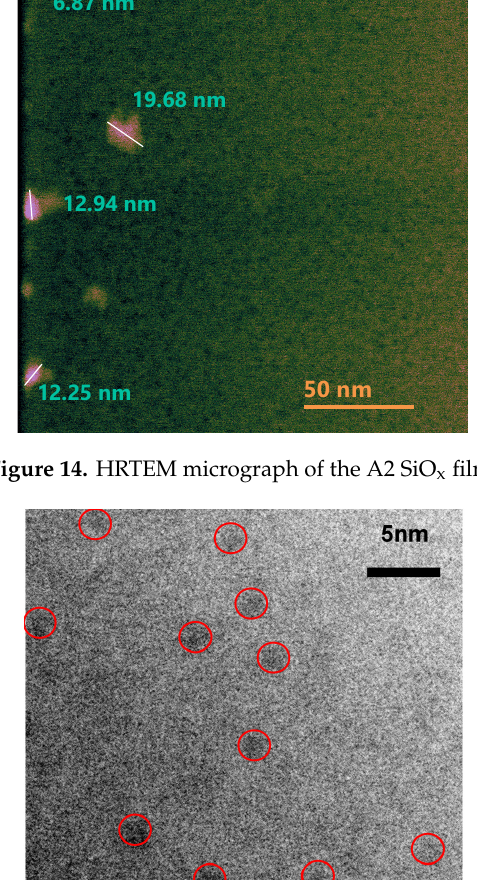
Figure 15. HRTEM micrograph of the D1SiO x film.